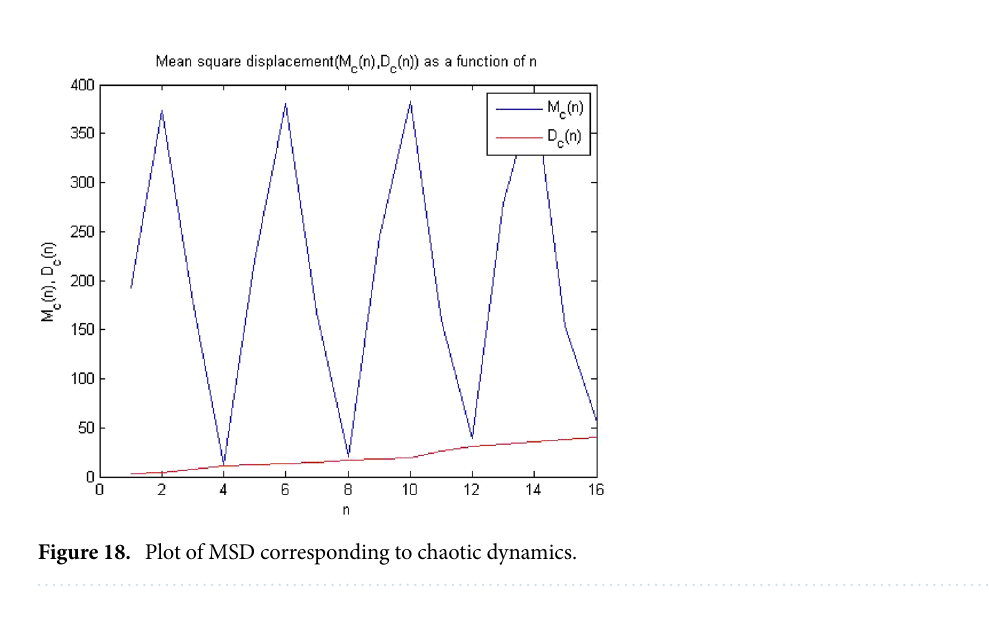
Figure 17. K = 0.0.983 in c vs K c plot which means dynamics is Chaotic.